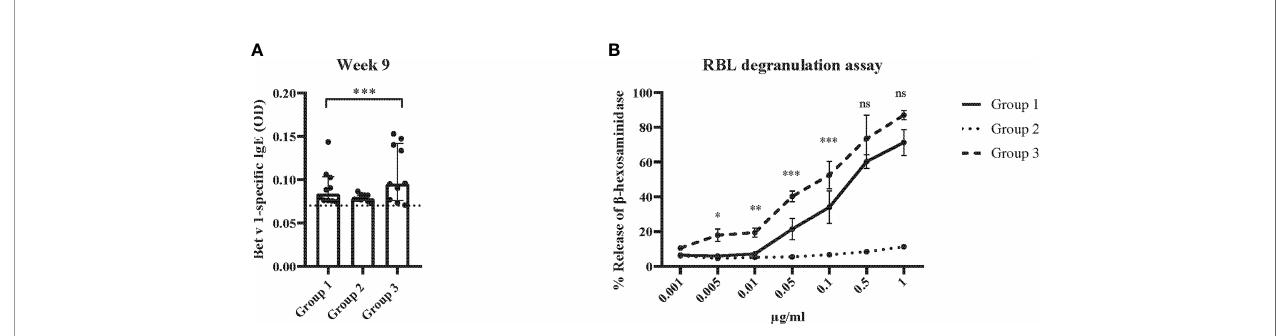
FIGURE 10 | Allergen-speci fi c IgE responses and basophil activation after fi ve prophylactic administrations of Bet v 1 peptides. (A) Bet v 1-speci fi c IgE antibody levels of the three mouse groups at week 9 ( (y-axes: optical density, OD levels, group medians with interquartile ranges). Dots represent means of duplicate determinations in individual mice with less than 10% deviation. Dotted horizontal bar indicates the cut-off levels for the antibody measurements. (B) Bet v 1-speci fi c basophil degranulation (0.001µg/ml-1µg/ml; x-axis) in the three mouse groups at week 9. The percentages of total b -hexosaminidase release are displayed on the y- axis.. Data were analyzed by a general linear model with a log link, comparing group 1 and 3 by linear contrast. Statistically signi fi cant differences between group 1 and group 3 are indicated (***P < 0.001, **P < 0.01, *P < 0.05). ns, not signi fi